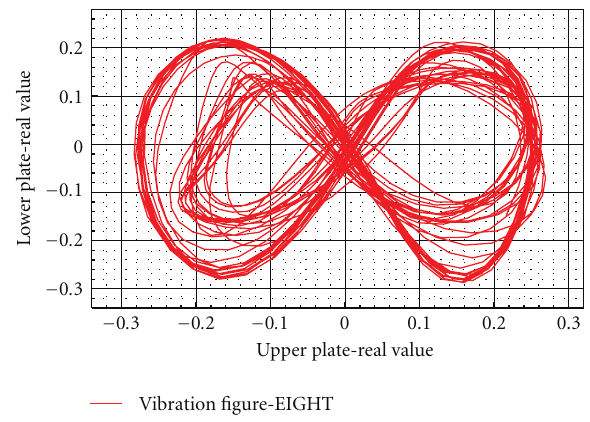
Figure 3: One example of vibration figure—EIGHT ( f D / f U = 8 / 4, /A . 5 / 0 . A D U = 0